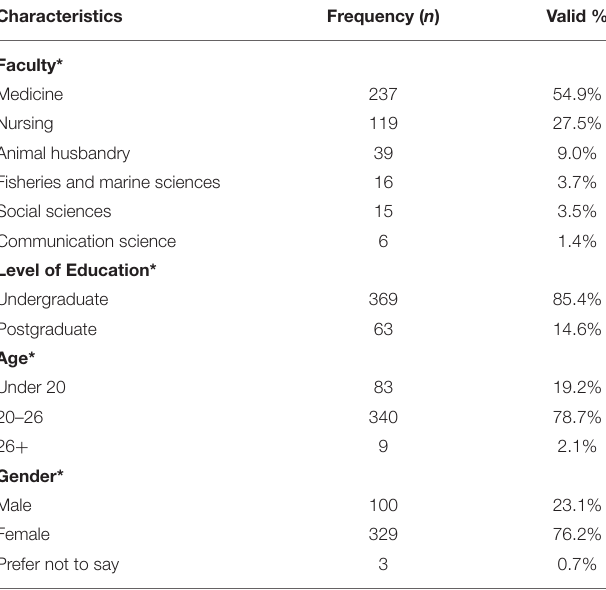
TABLE 1 | Sociodemographic characteristics of the study